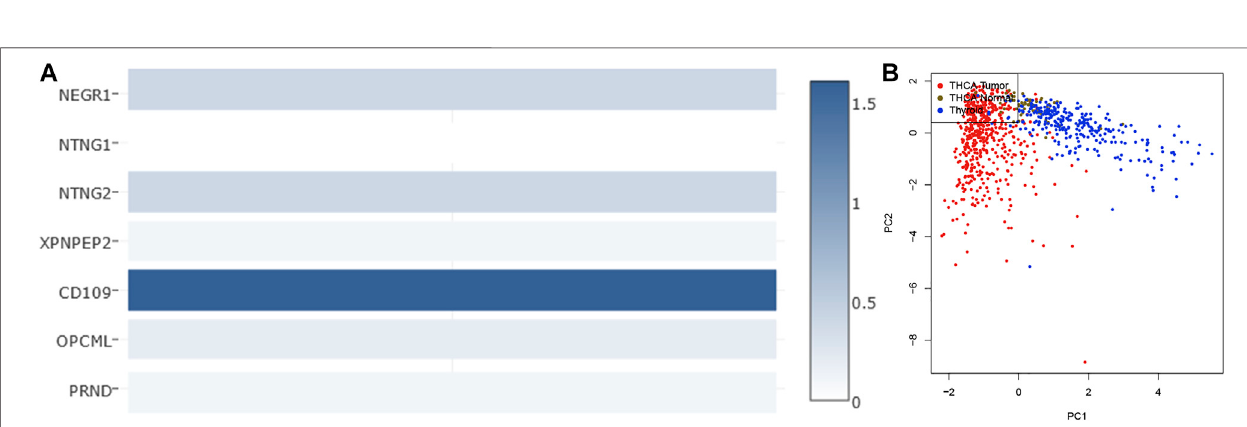
Frontiers in Genetics |